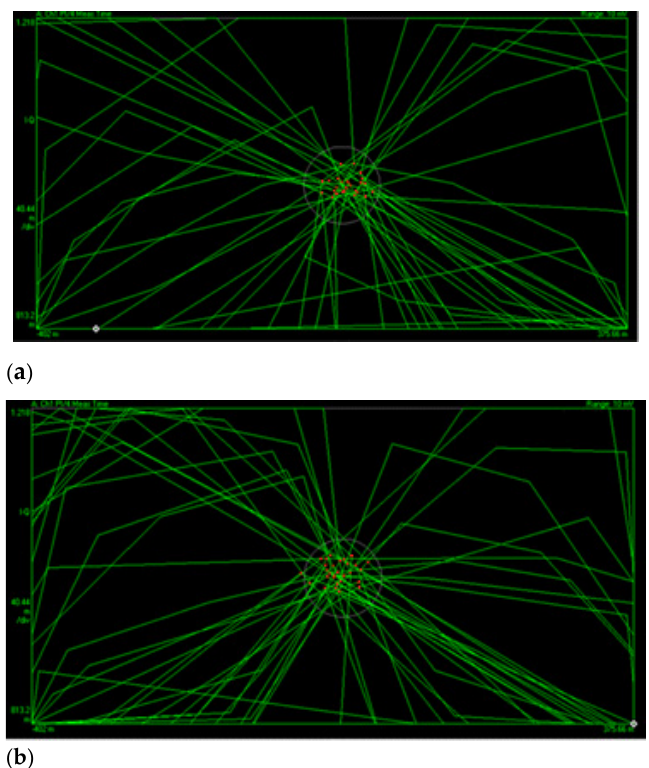
Figure 15. Detailed visualization of symbol states with respect to the error tolerance (circle): ( a ) symbol distribution for an EVM of 1.84%, ( b ) symbol distribution for an EVM of 2.91%.